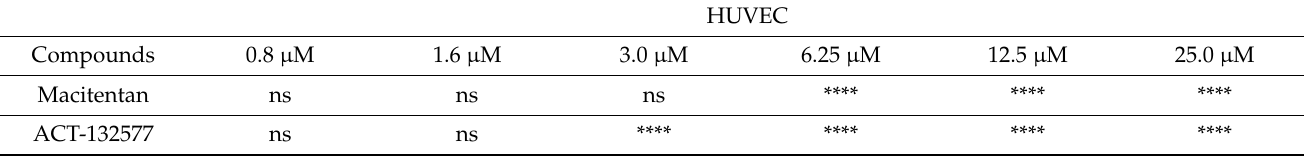
Table 3. HCMV infected HUVECs, MRC5 and RPE were treated with different concentrations of ETR antagonists or Ganciclovir and viral output was calculated from the percentage of IE-expressing cells one day after infection. These results were obtained from data in Figure